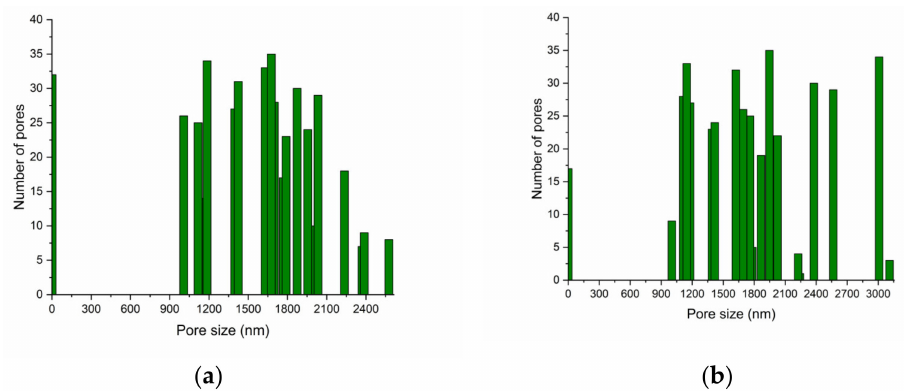
Figure 5. Average pore size calculated using ImageJ software for ( a ) PVA 72000 _PEBSA 50/50 and ( b ) PVA 145000 _PEBSA 50/50 .